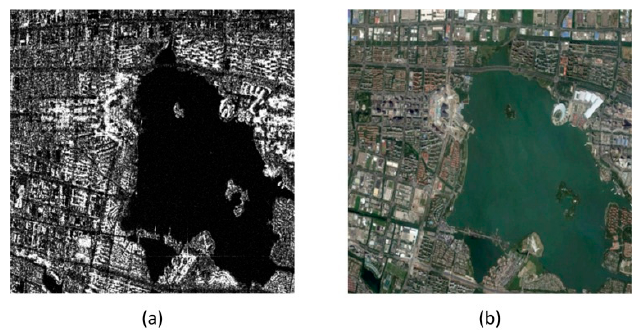
Figure 3. ( a ) The RADARSAT-2 and ( b ) the corresponding Google Earth image.